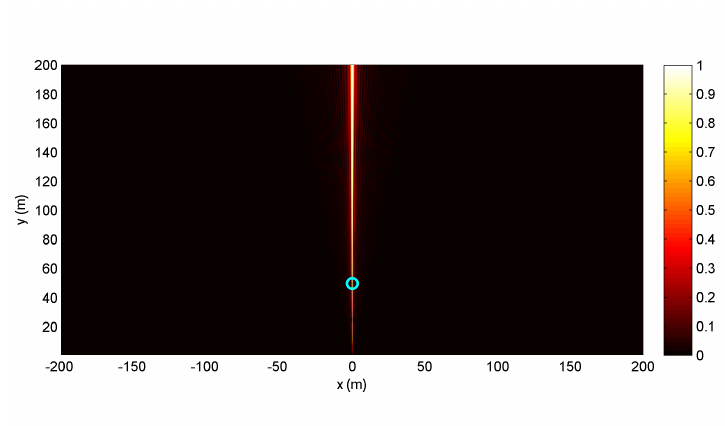
Figure 4. Image map of the correlation coefficient when the first terminal is fixed in the position marked with the circle and the second user is moved on the plane for the λ /2 equispaced array.